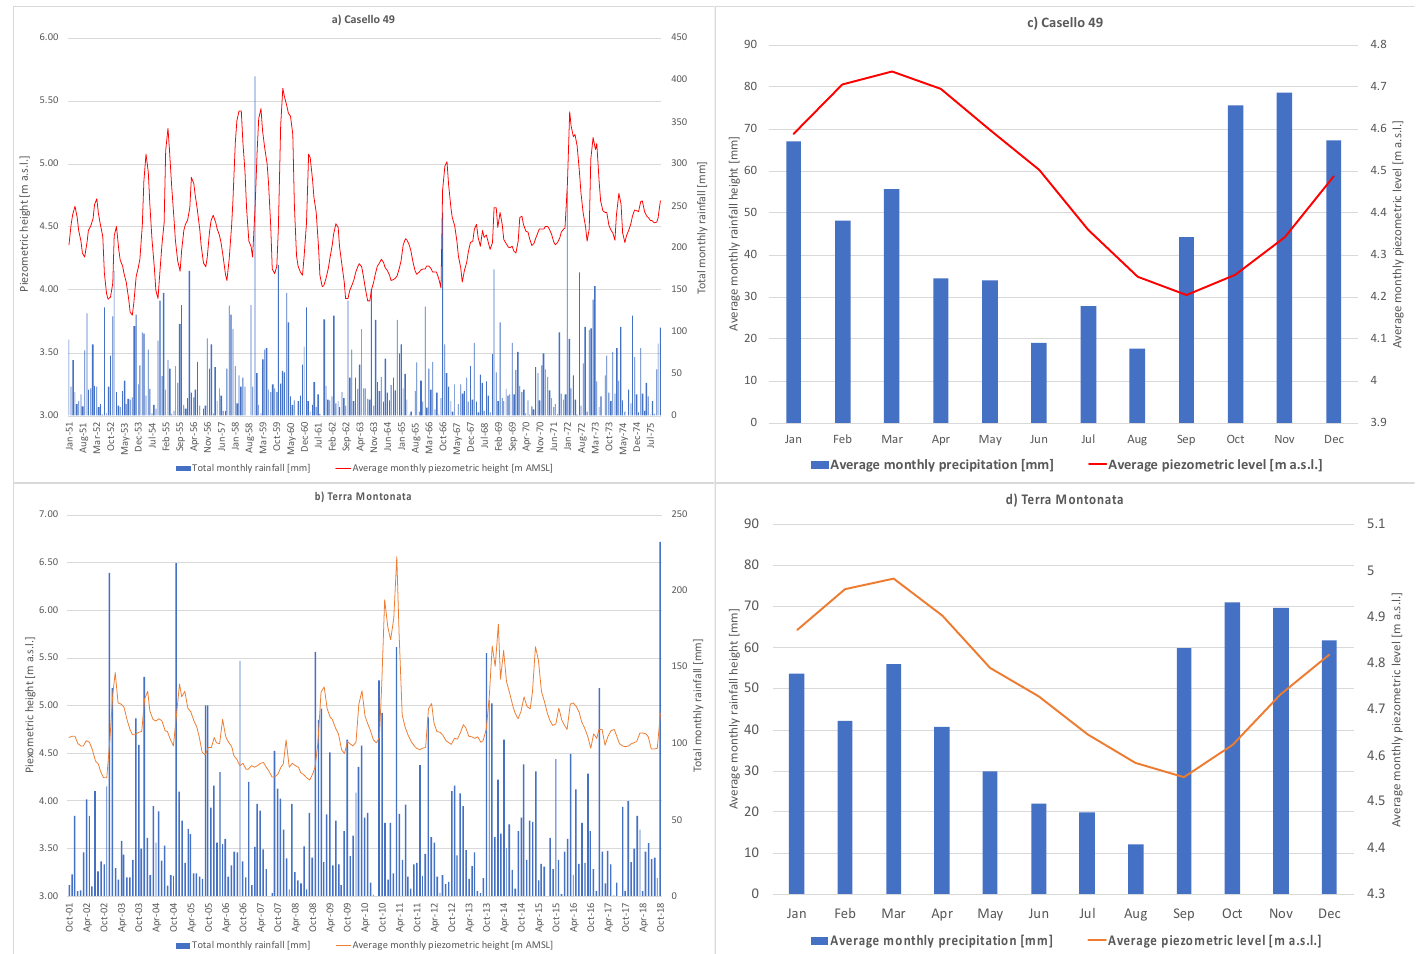
Figure 3. ( a ) Time plot of the average monthly piezometric levels and total monthly rainfall of Casello 49; ( b ) time plot of average monthly piezometric levels and total monthly rainfall of Terra Montonata; ( c ) average monthly piezometric levels and precipitations of Casello 49; ( d ) average monthly piezometric levels and precipitations of Terra Montonata.